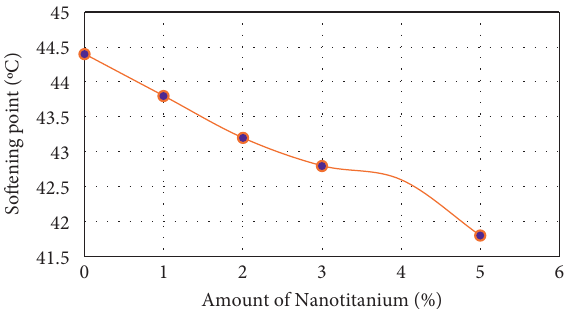
Figure 8: The softening point of nano TiO